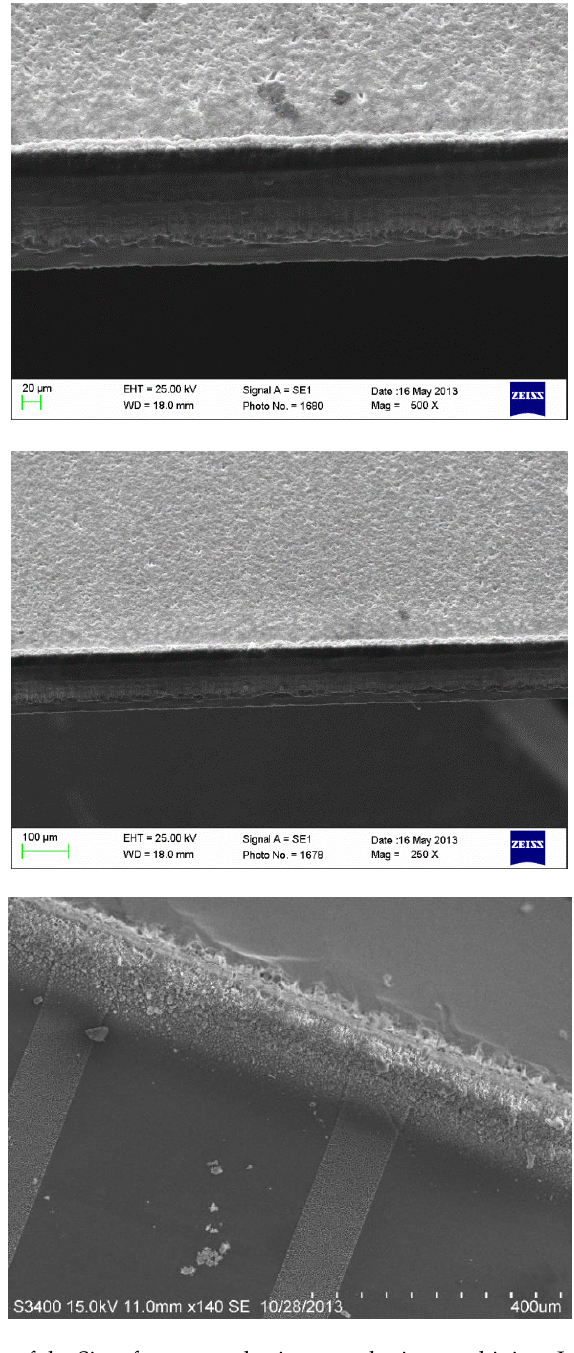
Figure 4. SEM images of the Si wafers post sub-picosecond micromachining. Laser beam parameters: 650 fs, 343 nm, 200 kHz, 27.5 µJ; processing parameters: 7 mm/s, 20 pattern repetitions.